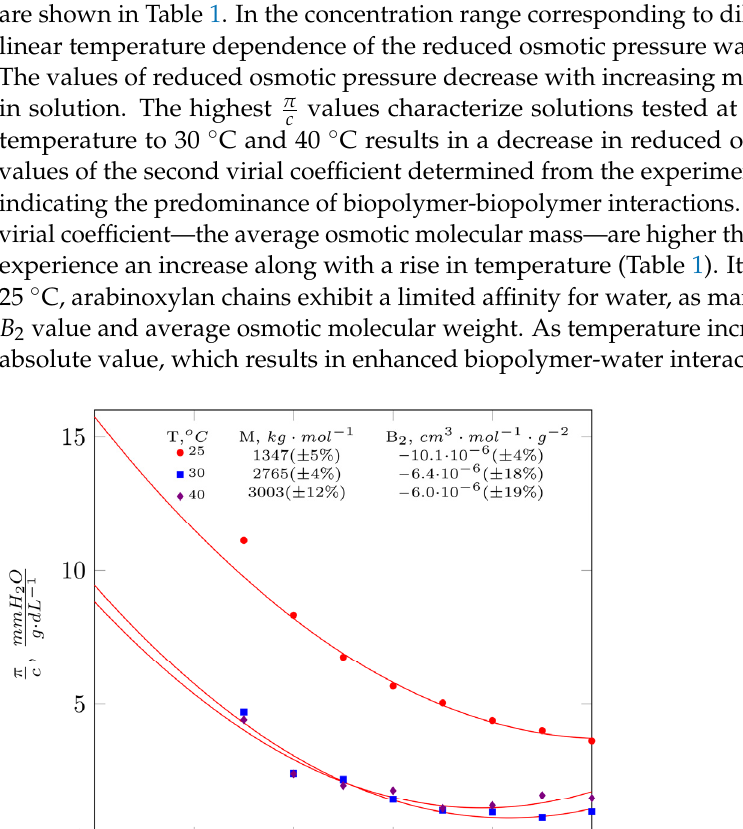
Figure 2. Reduced osmotic pressure as a function of extract concentration at selected temperatures.